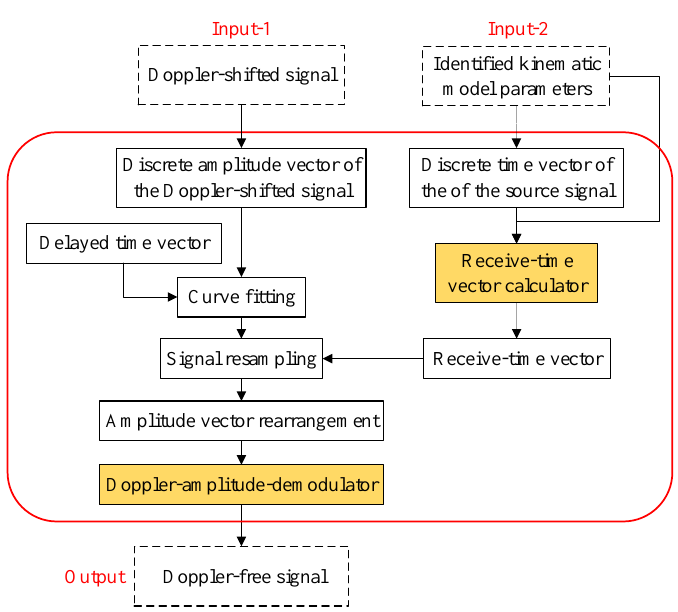
Figure 7. Procedure of the signal